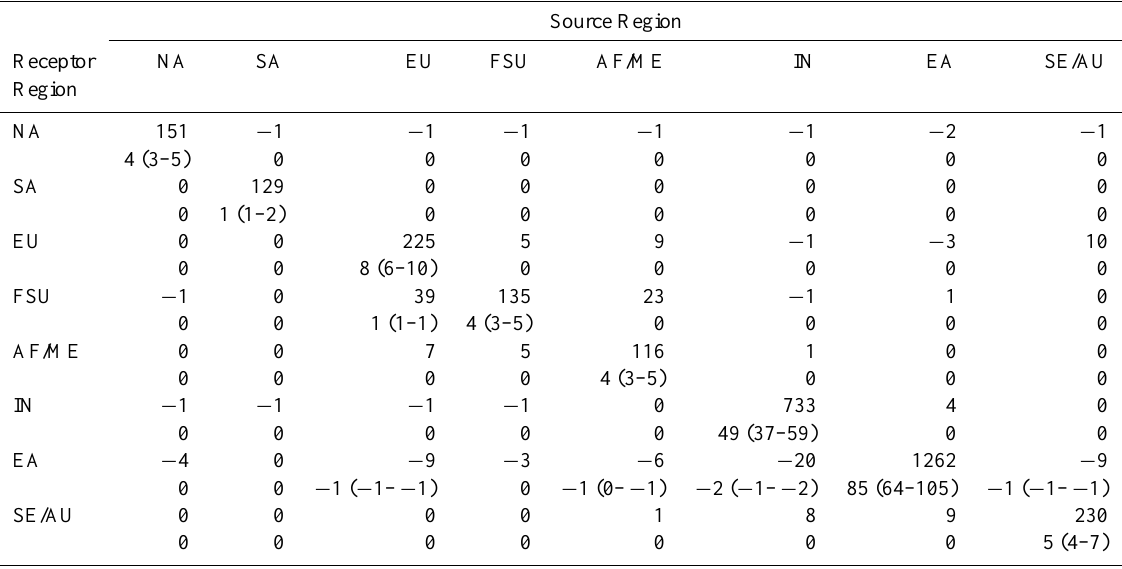
Table 2. Reduction in population-weighted average PM 2 . 5 concentration (first row for each receptor region, ngm − 3 ) and annual avoided premature cardiopulmonary and lung cancer deaths (second row, thousands) in each receptor region after halving anthropogenic BC emissions in each source region. Confidence intervals (95%, in parentheses) reflect uncertainty in the CRF only.